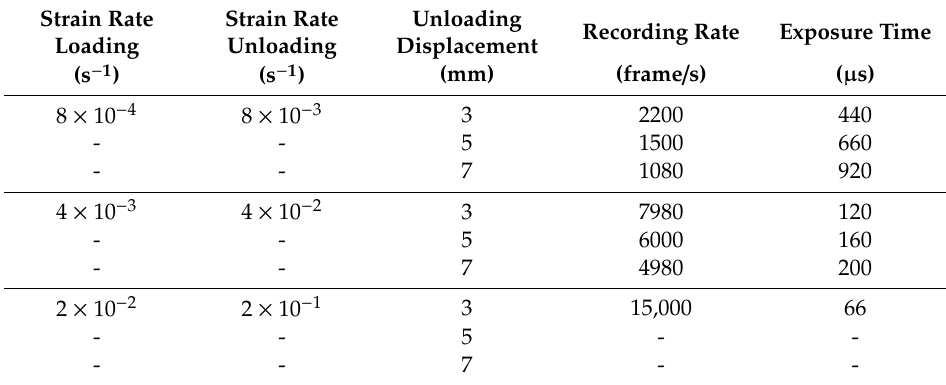
Figure 3. Testing fixture. Table 1. PHANTOM camera’s parameters.